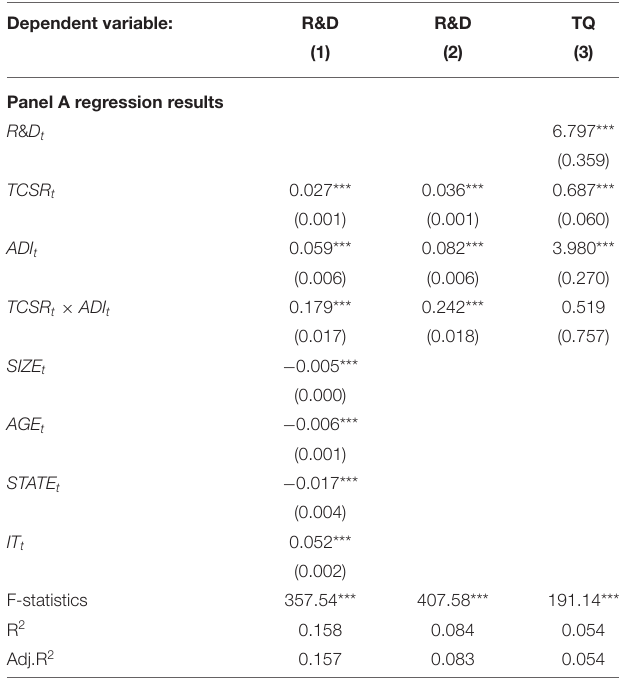
TABLE 4 | TCSR and CFP: The mediating effects of innovation moderated by